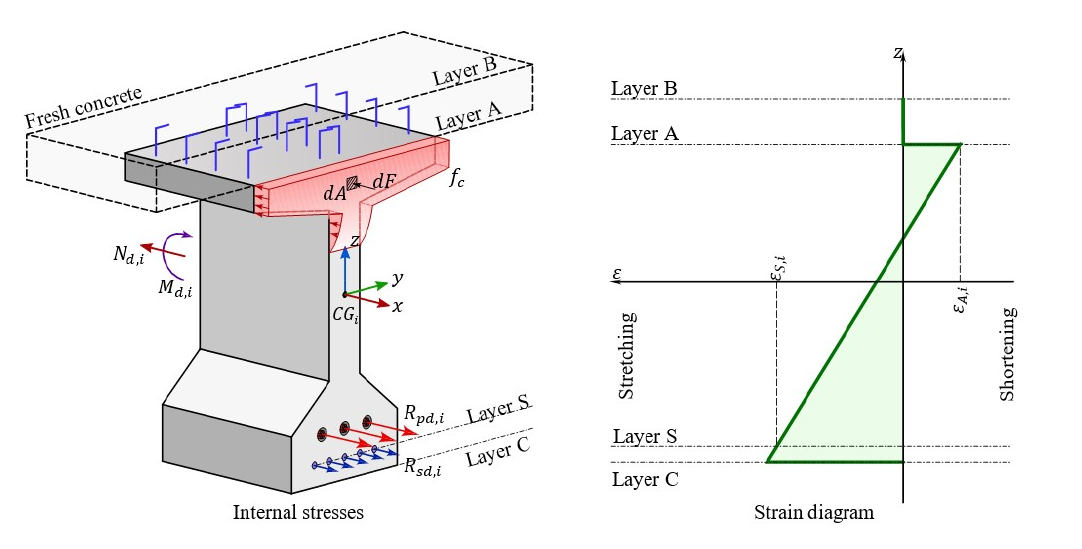
Figure 3. Internal stresses and strain diagram in initial step.